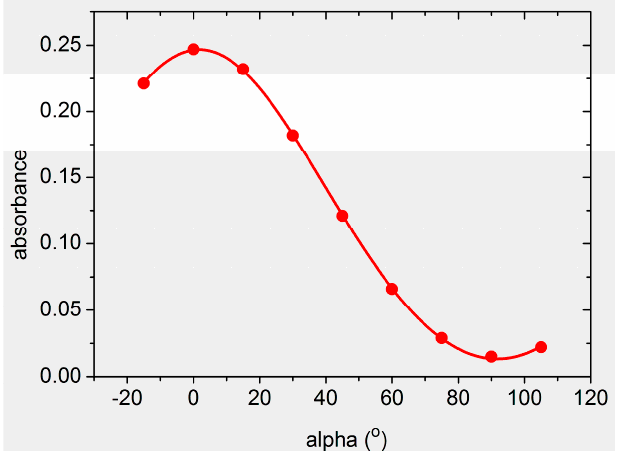
Figure 4. Angular dependence of the amplitude of the OH – absorption band at 3494 cm − 1 in 1 atomic% Yb-doped sLN crystal (dots are experimental points, the solid line is a fitted curve using the function taken from Ref. [21]).